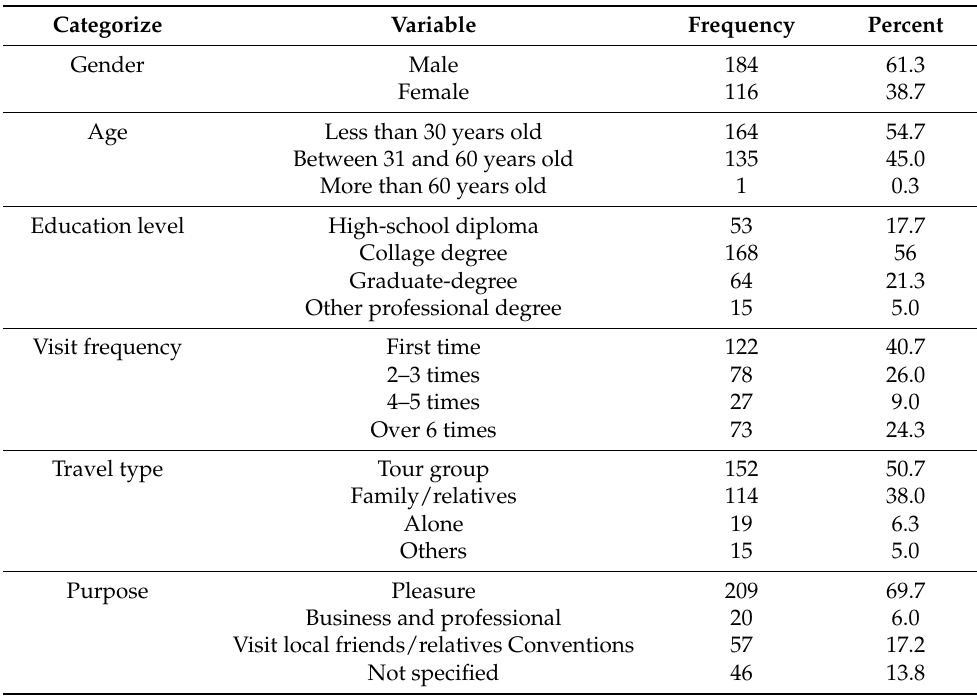
Table 2. Demographic information of samples ( n = 300).